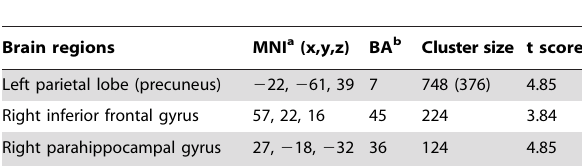
Table 3. Significantly thinning cortical regions between PTSD and non-PTSD